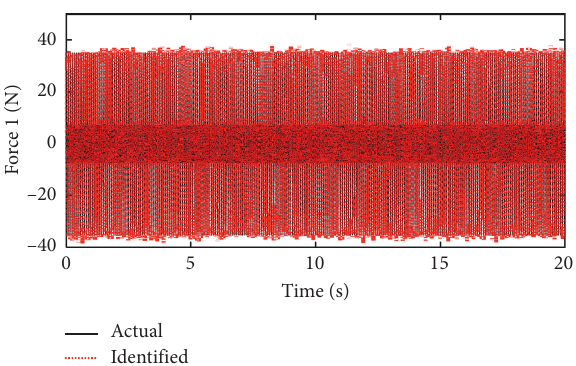
1 through fusing data.